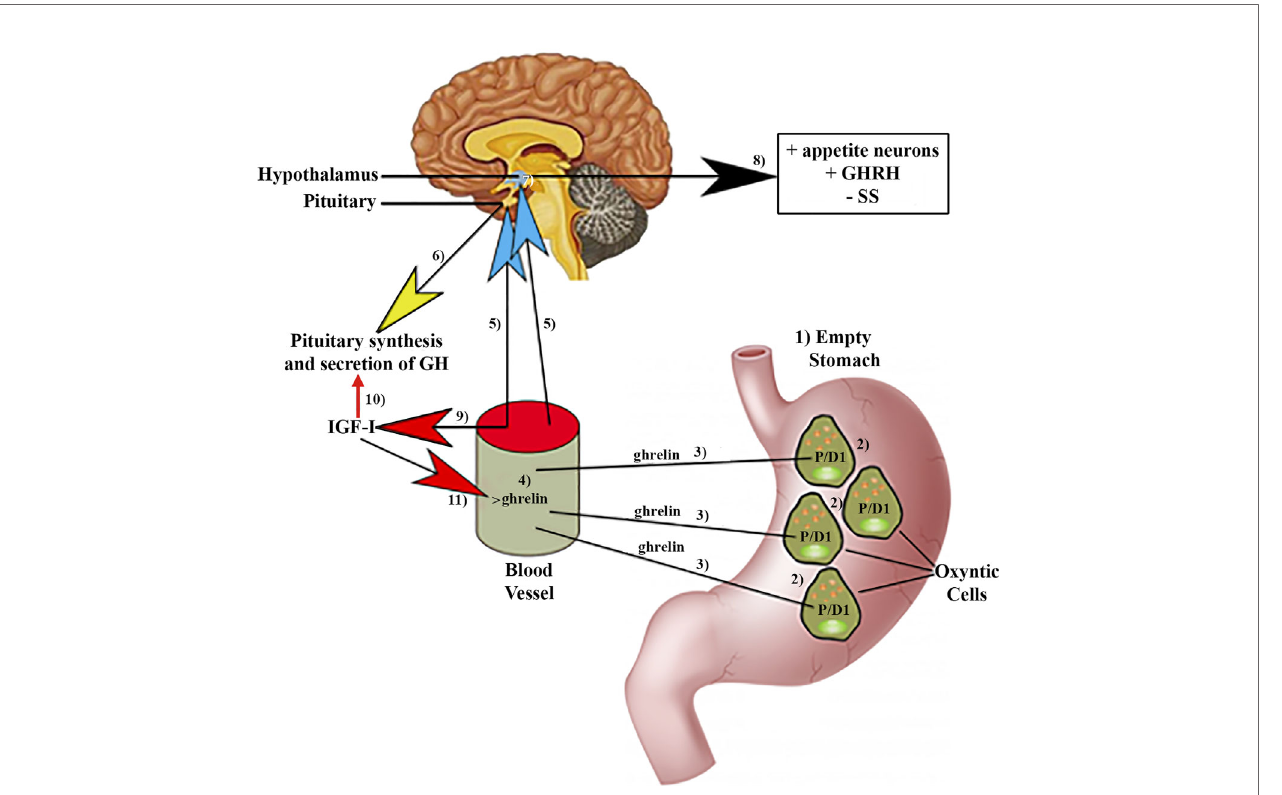
FIGURE 1 | Ghrelin production by the stomach and effects of ghrelin on pituitary GH synthesis and secretion. (1)In fasting situations, an empty stomach increases ghrelin production in speci fi c P/DI cells (2) in humans located in oxyntic cells. Then, ghrelin is released into the circulation (3, 4) from where it reaches (5) the pituitary gland, inducing the synthesis and secretion of GH (6). Circulating ghrelin also reaches the hypothalamus (7), where it induces stimulation (8) of the appetite neurons, GHRH, and inhibits the release of SS. (9)Furthermore, circulating ghrelin inhibits the inhibitory effects of IGF-I on the synthesis and pituitary secretion of GH (10). In turn, IGF-I inhibits the increase in circulating ghrelin (11) produced in response to fasting. Blue arrows: stimulation; Red arrows: Inhibition; Yellow arrow: synthesis and secretion of GH; Black arrow: Hypothalamic effects of ghrelin; +, stimulation; − , inhibition.